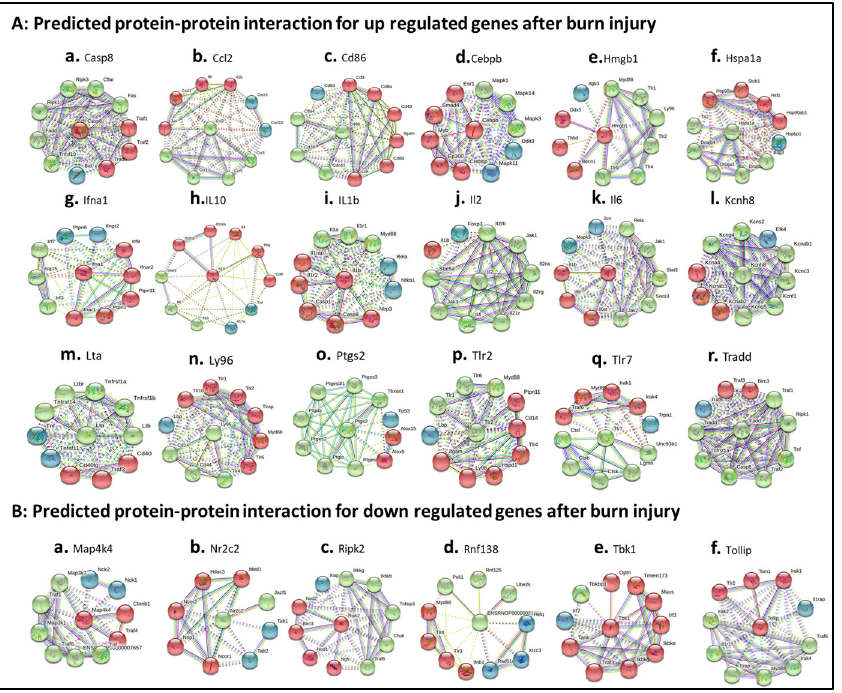
Figure 7. Burn-injury-induced TLR-related DEP–protein interaction networks. ( A ) burn-injury-induced up-regulated TLR-related DEP–protein interactions including Casp8 ( A.a ), Ccl2 ( A.b ), Cd86 ( A.c ), Cebpb ( A.d ), Hmgb1 ( A.e ), Hspa1a ( A.f ), Ifna1 ( A.g ), IL10 ( A.h ), IL1b ( A.i ), IL2 ( A.j ), IL6 ( A.k ),